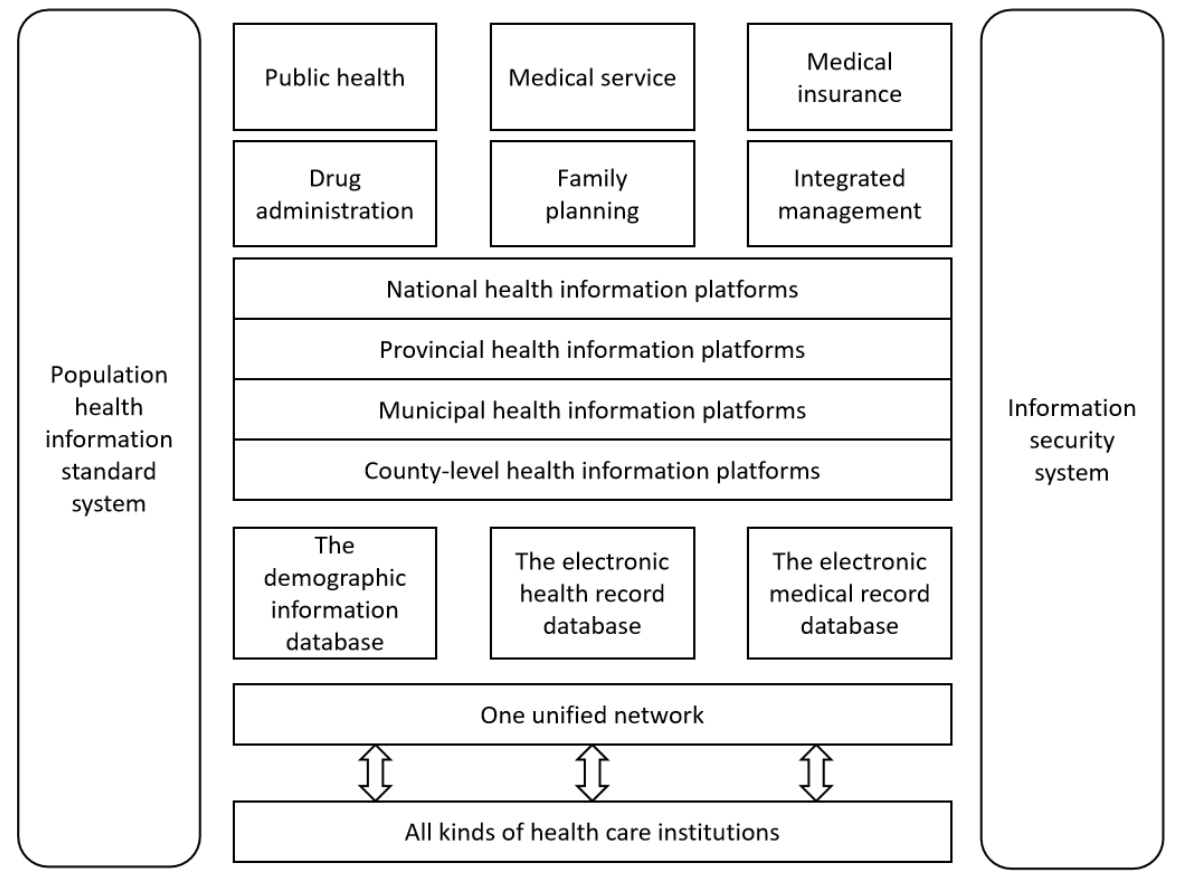
Figure 1. The “4631-2 framework” of health